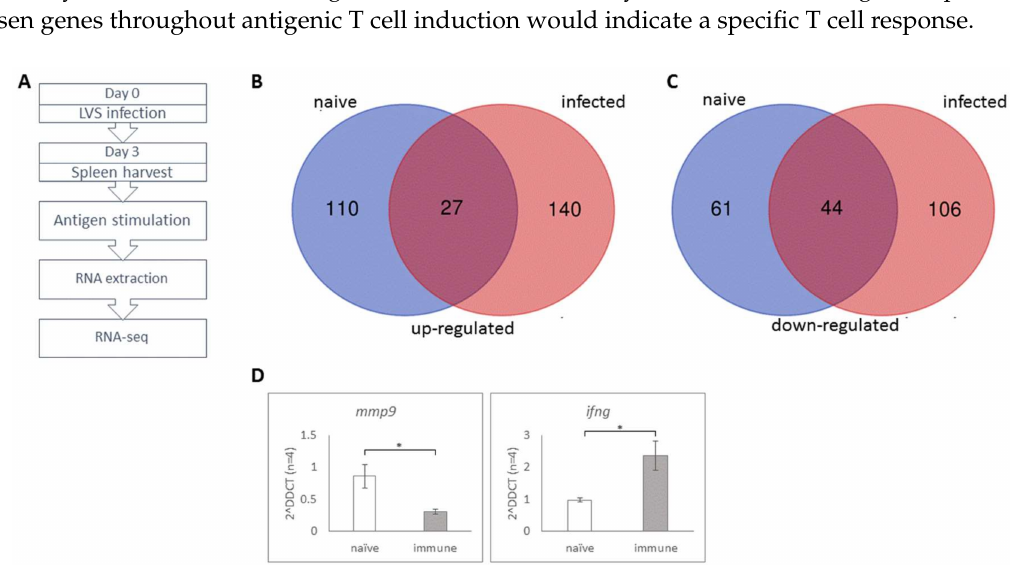
Figure 6. RNA-seq analysis. ( A ) Experimental flow chart: Splenocytes from five naive mice and five LVS-infected mice were stimulated in situ with UViLVS for 3 h. Total RNA was extracted and mRNA was sequenced. The number of genes that were significantly up-regulated ( B ) or down-regulated ( C ) in infected and naïve mice in response to antigen stimulation, as described in the text. ( D ) Real-time PCR validation of mmp9 and ifng genes in splenocytes from LVS-infected versus naïve mice. The expression level was normalized to the hprt gene. * p <